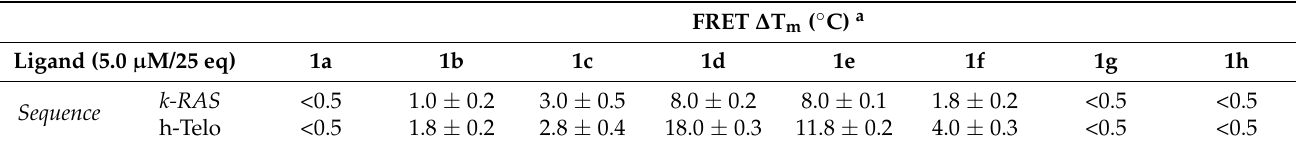
Table 1. FRET-Melting ∆ T m values for k-RAS G4 and h-Telo G4 at 0.2 µ M FAM/TAMRA-labelled DNA concentration, in presence of the non-methylated dicarboxamide